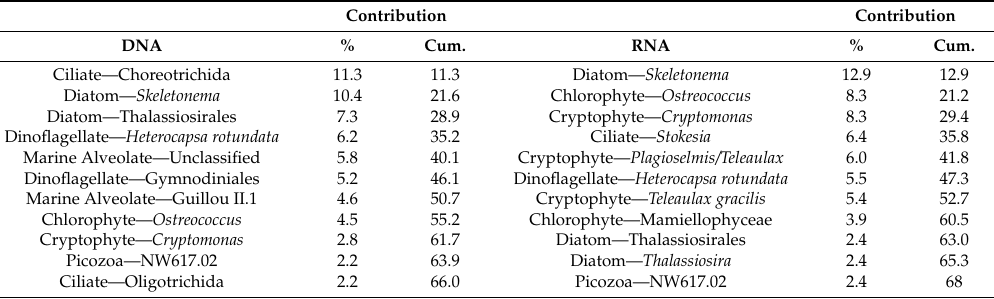
Table 3. Similarity percentage (SIMPER) analysis listing the top 12 eukaryotic OTUs which contributed to the dissimilarity between freshwater (POR, IDO) and transition and marine sites (IAC, STS, TRP, PAP; full names of sites given in Table 2) for DNA- and RNA-amplified samples. (Cum. =